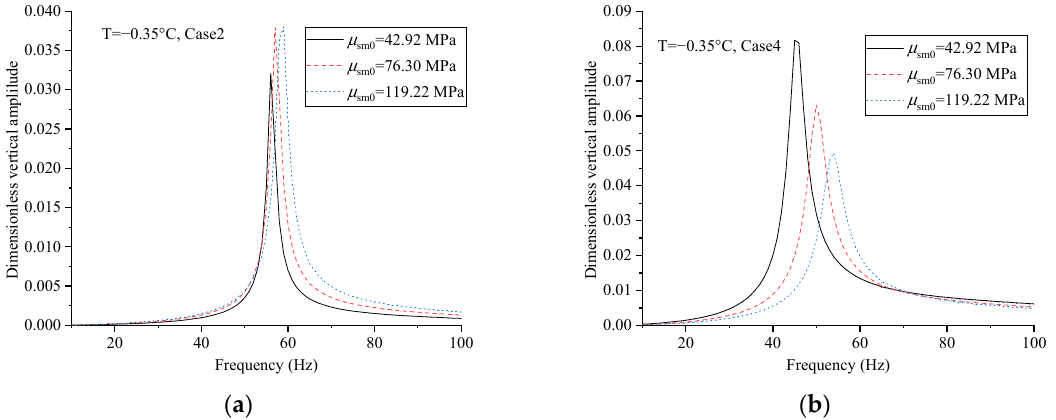
Figure 8. Effects of the soil modulus on the amplitude–frequency curves of the pile foundation on ( a ) Case 2 and ( b ) Case 4.